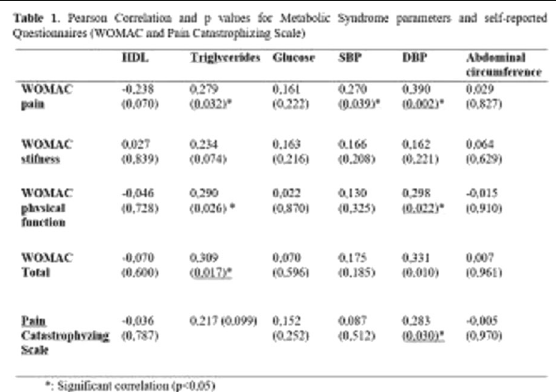
Table 1 (abstract P384). Pearson Correlation and p values for Metabolic Syndrome parameters and self-reported Questionnaires (WOMAC and Pain Catastrophizing